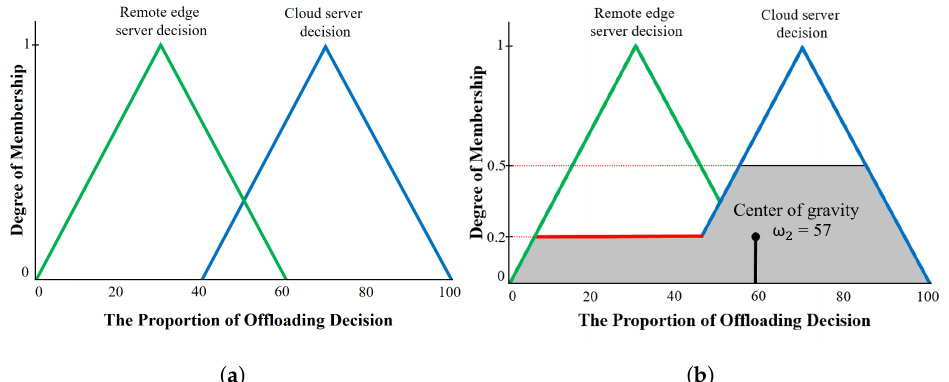
Figure 8. Defuzzification: ( a ) Membership functions of fuzzy outputs. ( b ) Crisp output calculation using